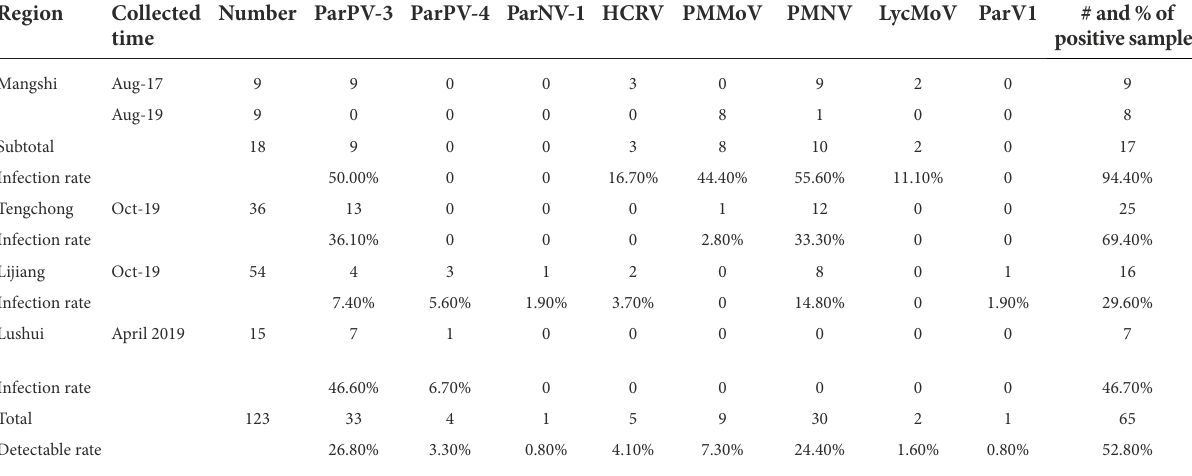
TABLE 1 Number of positive samples and infection rate of individual viruses in Paris yunnanensis.